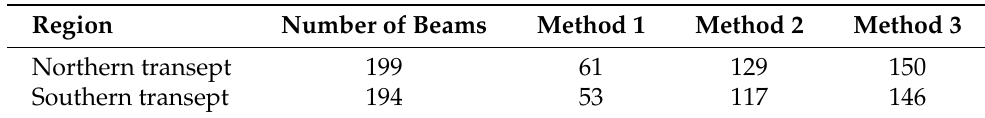
Table 3. Completeness of the